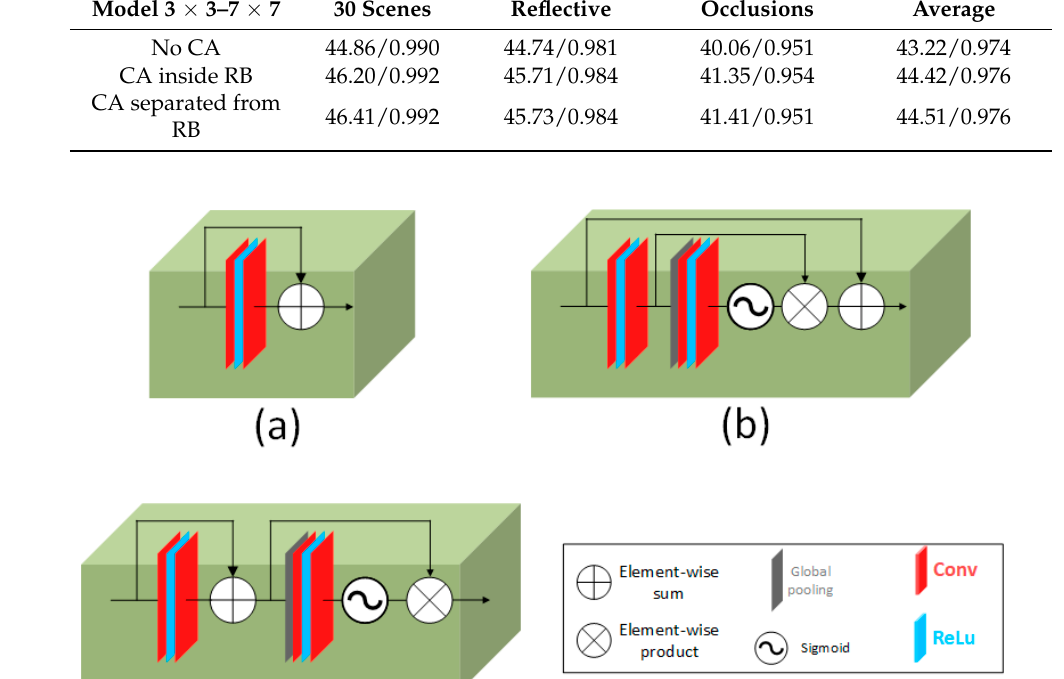
Table 6. Investigating the channel attention mechanism (CA) effect on the proposed architecture.